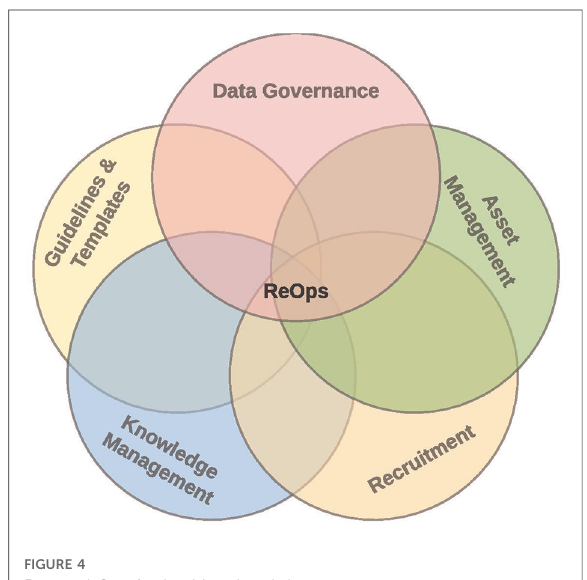
FIGURE 4 ResearchOps for health-related